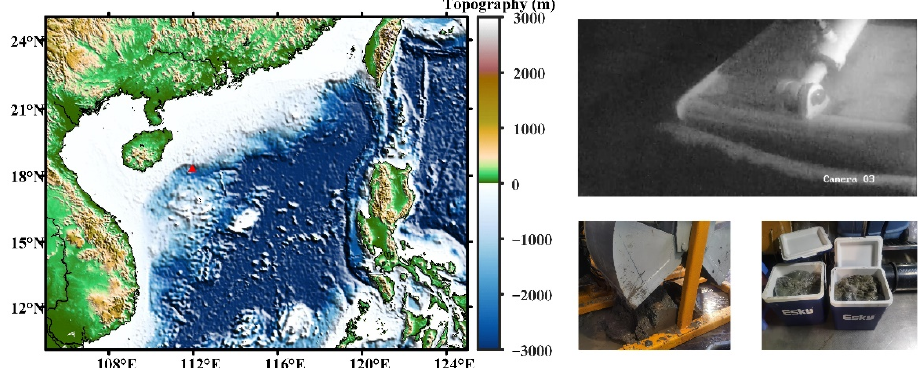
Figure 1. Schematic diagram of sediment samples.